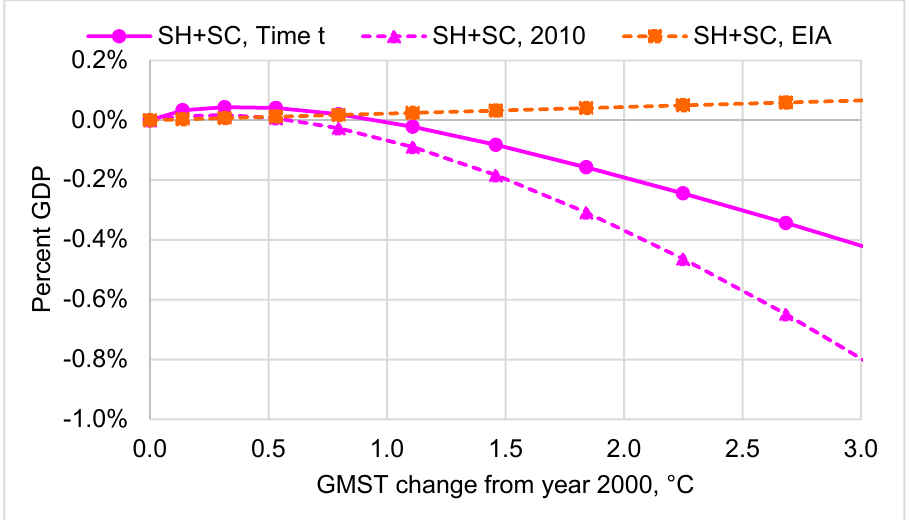
Figure 9. Economic impact of US energy expenditure as functions of GMST change, relative to 2000. Pink solid line is the Julia FUND3.9 projection. Pink dashed line is the projection with non-temperature drivers constant at 2010 values. The orange dashed line is from the EIA data.